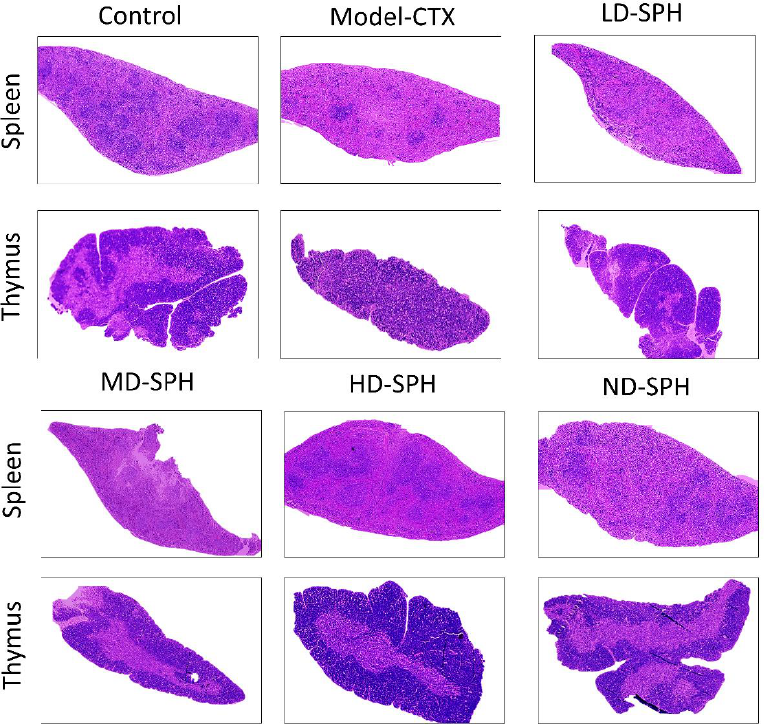
Figure 5. SPH impacts on spleen and thymus tissues histology. Magnification 10×, Scale bar: 100 µm.